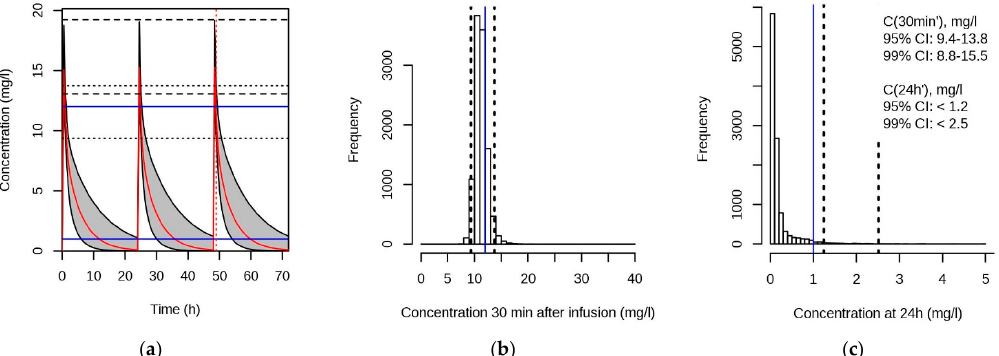
Figure 6. Plasma concentrations simulated with the final model to reach C (30 min’) between 10 and 12 mg/L. Simulations for 30 min infusion time. ( a ) Plasma-concentration time curves. Grey, 95% CI of the simulated concentrations (from 100 simulations per subject, i.e., 10,900 simulations in total). Red, median C ( t ) at each time point. Blue horizontal lines show recommended maximal trough (1 mg/L), and maximal C (30 min’) level for long-duration treatment (12 mg/L). Horizontal dotted and broken lines, 95% CI of the simulated C (30 min’) and maximal levels (at infusion stop), respectively. Vertical dotted red line, time point for C (30 min’). ( b ) Distribution of the simulated C (30 min’). Vertical blue line, 12 mg/L. Vertical black broken lines, 95% CI of the simulated C (30 min’). ( c ) Distribution of the simulated C (24 h’). Vertical blue line, 1 mg/L. Vertical black broken lines, 95% and 99% upper CI of the simulated C (24 h’). The 95% and 99% CI values for the simulated C (30 min’) and C (24 h’) are provided in panel ( c ).